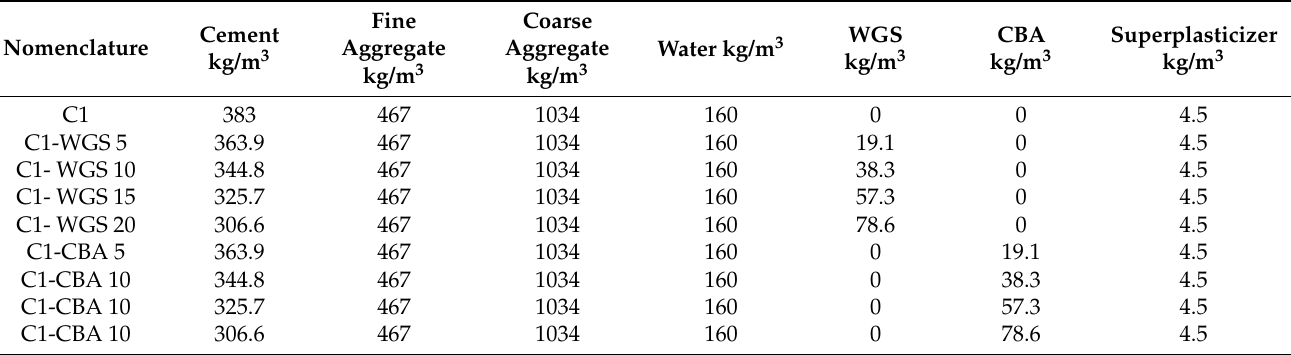
Table 3. Defining cases for each mix design sample.